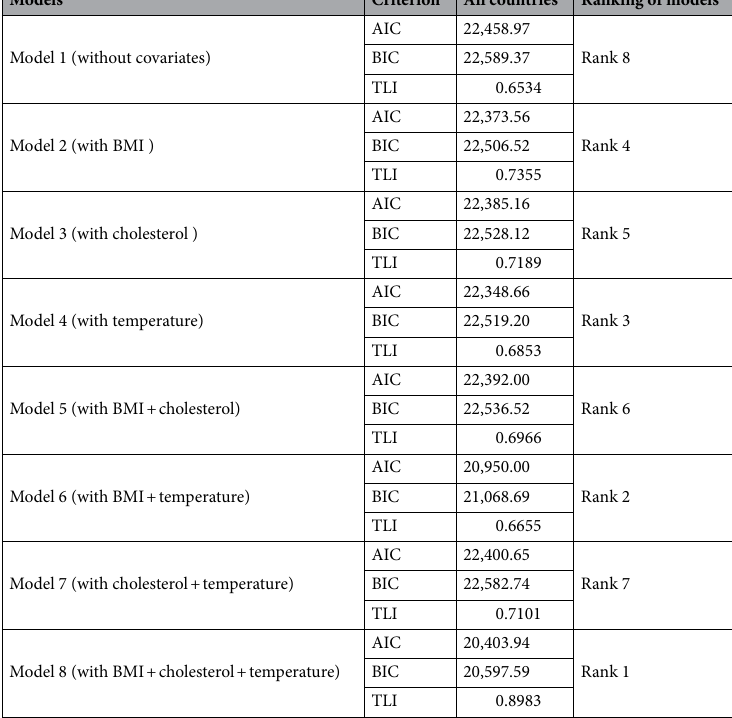
Models Criterion All countries Ranking of